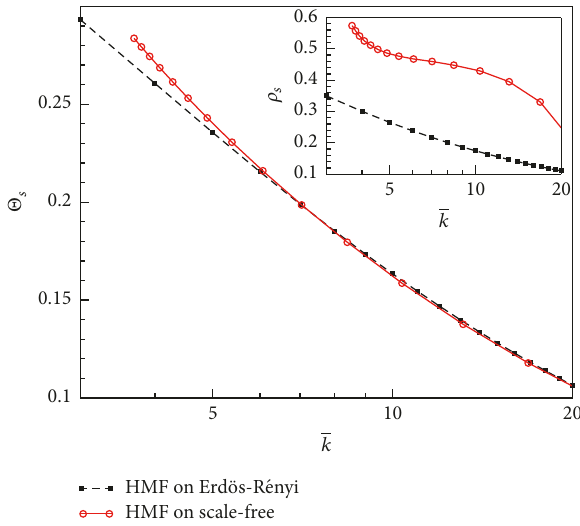
Figure 2: Asymptotic value of the cooperator density for the best- shotgamewithBRdynamicsforErd¨os-R´enyiandscale-freerandom graphs (with 𝑘 min = 3 and varying 𝛾 ): Θ 𝑠 (main panel) and 𝜌 𝑠 (inset) versus the average degree 𝑘 , obtained by numerically solving